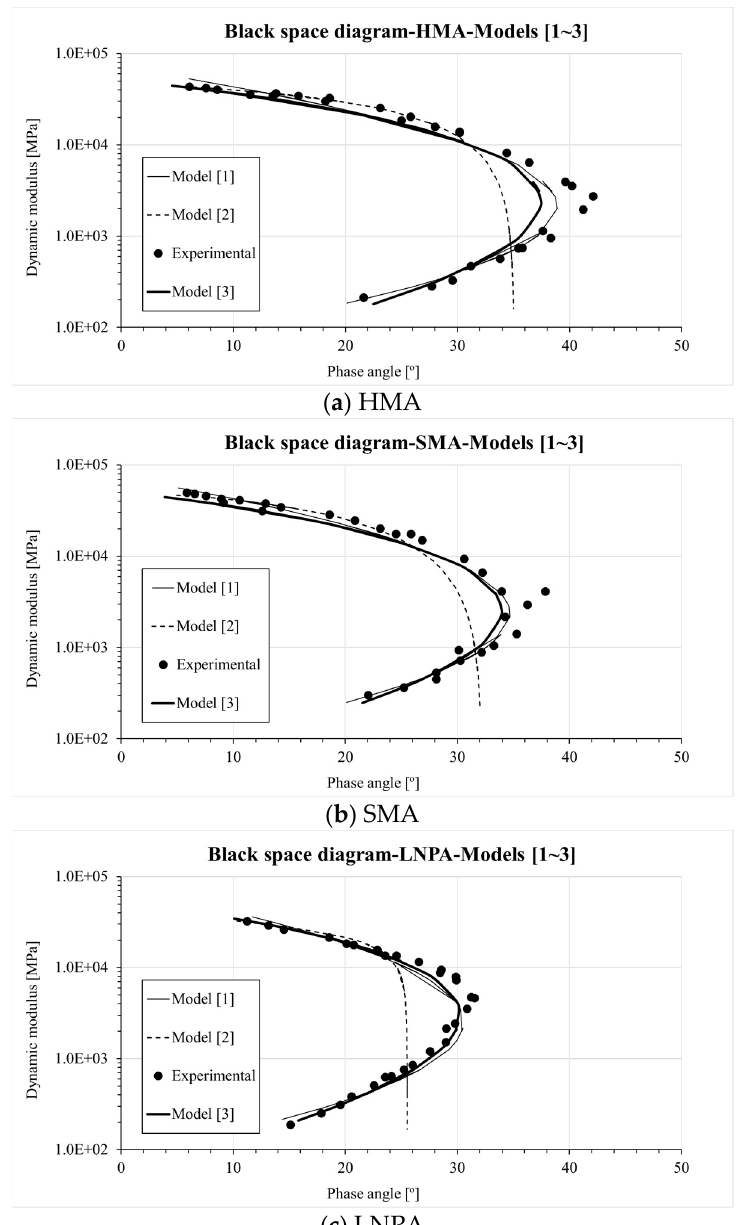
Figure 4. Black diagram-|E*( ω )| versus δ ( ω )-for the tested asphalt mixtures (( a ) HMA, ( b ) SMA, ( c ) LNPA). A simple t -test (i.e., hypothesis test) with a 5% significance level was adopted to statistically estimate the difference in the fitting capability of the three master curves models. The range of t -test